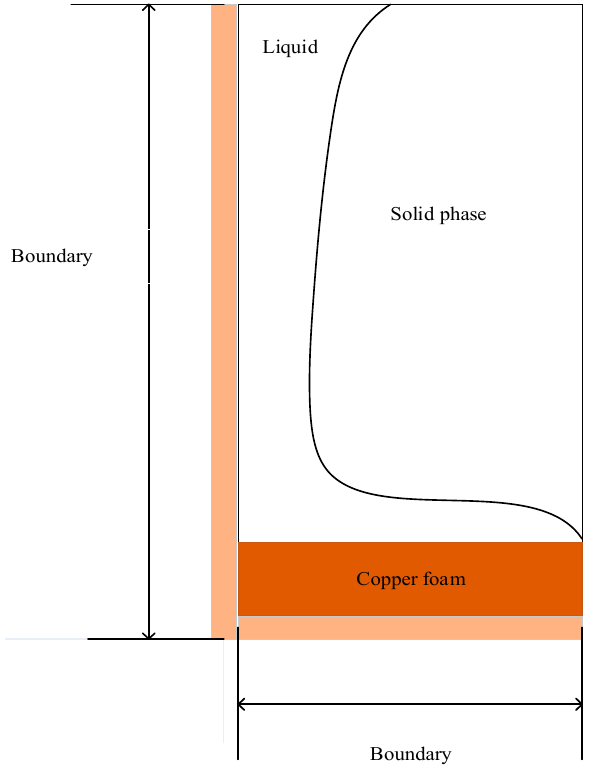
Energies 2023 , 16 , x FOR PEER REVIEW Figure 12. Schematic of the solid–liquid interface. Figure 12. Schematic of the solid–liquid interface.